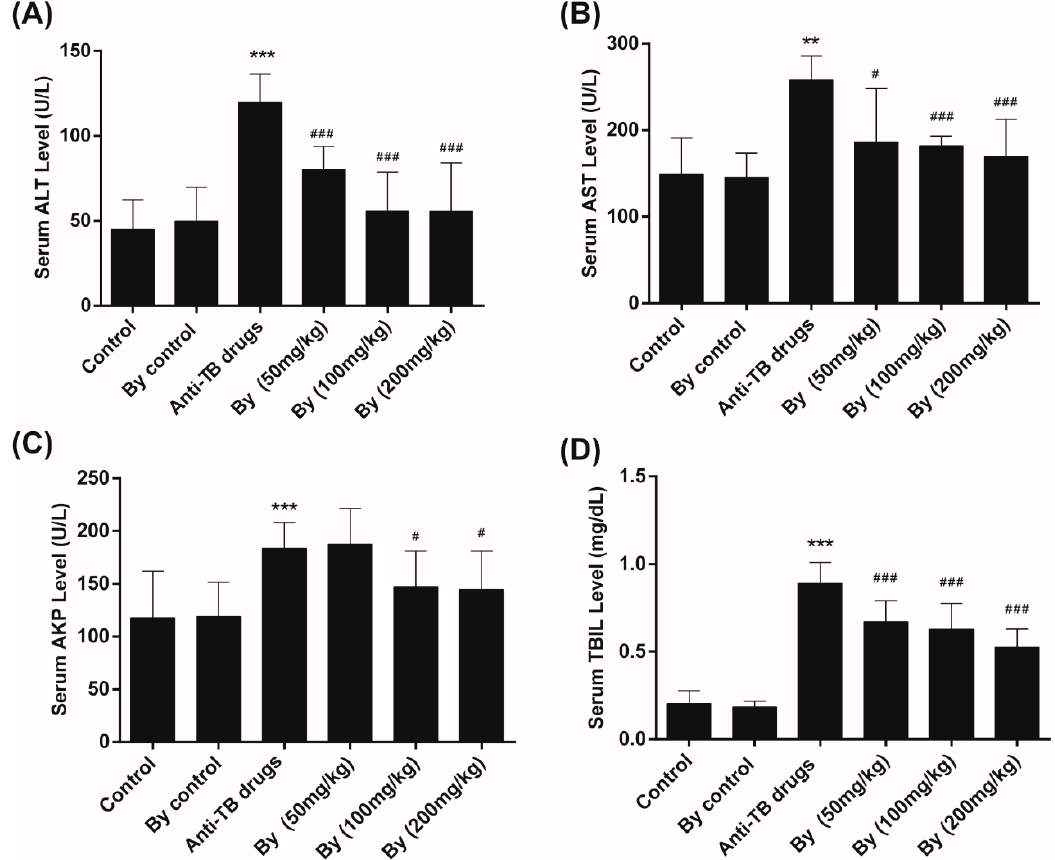
Figure 2. Effect of bicyclol on the elevation of serum ALT ( A ), AST ( B ), AKP ( C ), and TBIL ( D ) in anti-TB drug intoxicated rats. Bicyclol (50, 100, 200 mg/kg) was administered orally to rats for 30 days. Data were expressed as means ± SD ( n = 10). **, p < 0.01, ***, p < 0.001 vs. control group; # , p < 0.05, ### , p < 0.001 vs. anti-TB drug intoxicated group.